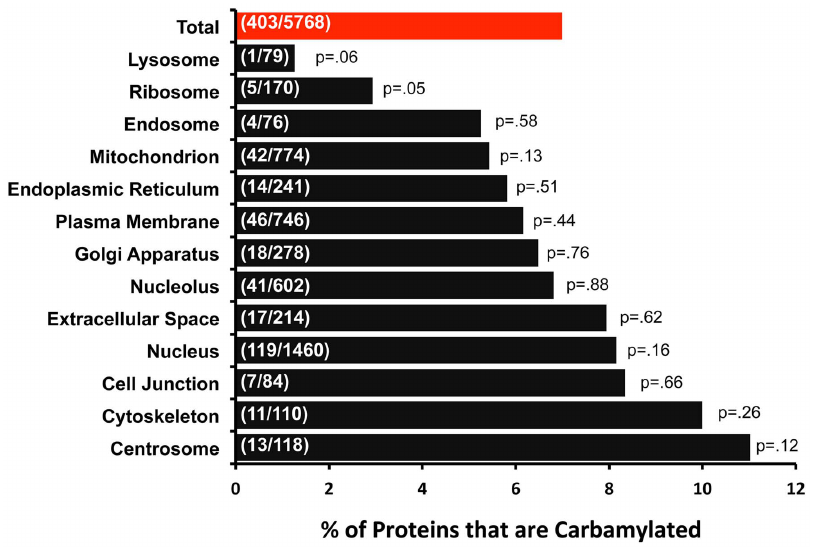
Figure 6. Gene Ontology Cellular Component analysis reporting percent of proteins identified in various cellular structures that were found to be carbamylated. The overall total is shown as a red bar. Fraction in bars show number of carbamylated/(carbamylated + non- carbamylated) proteins. A total of 5768 proteins were detected in all samples counting proteins with both carbamylated and non-carbamylated peptides. The P values were obtained using a chi-squared test versus ‘‘Total’’.